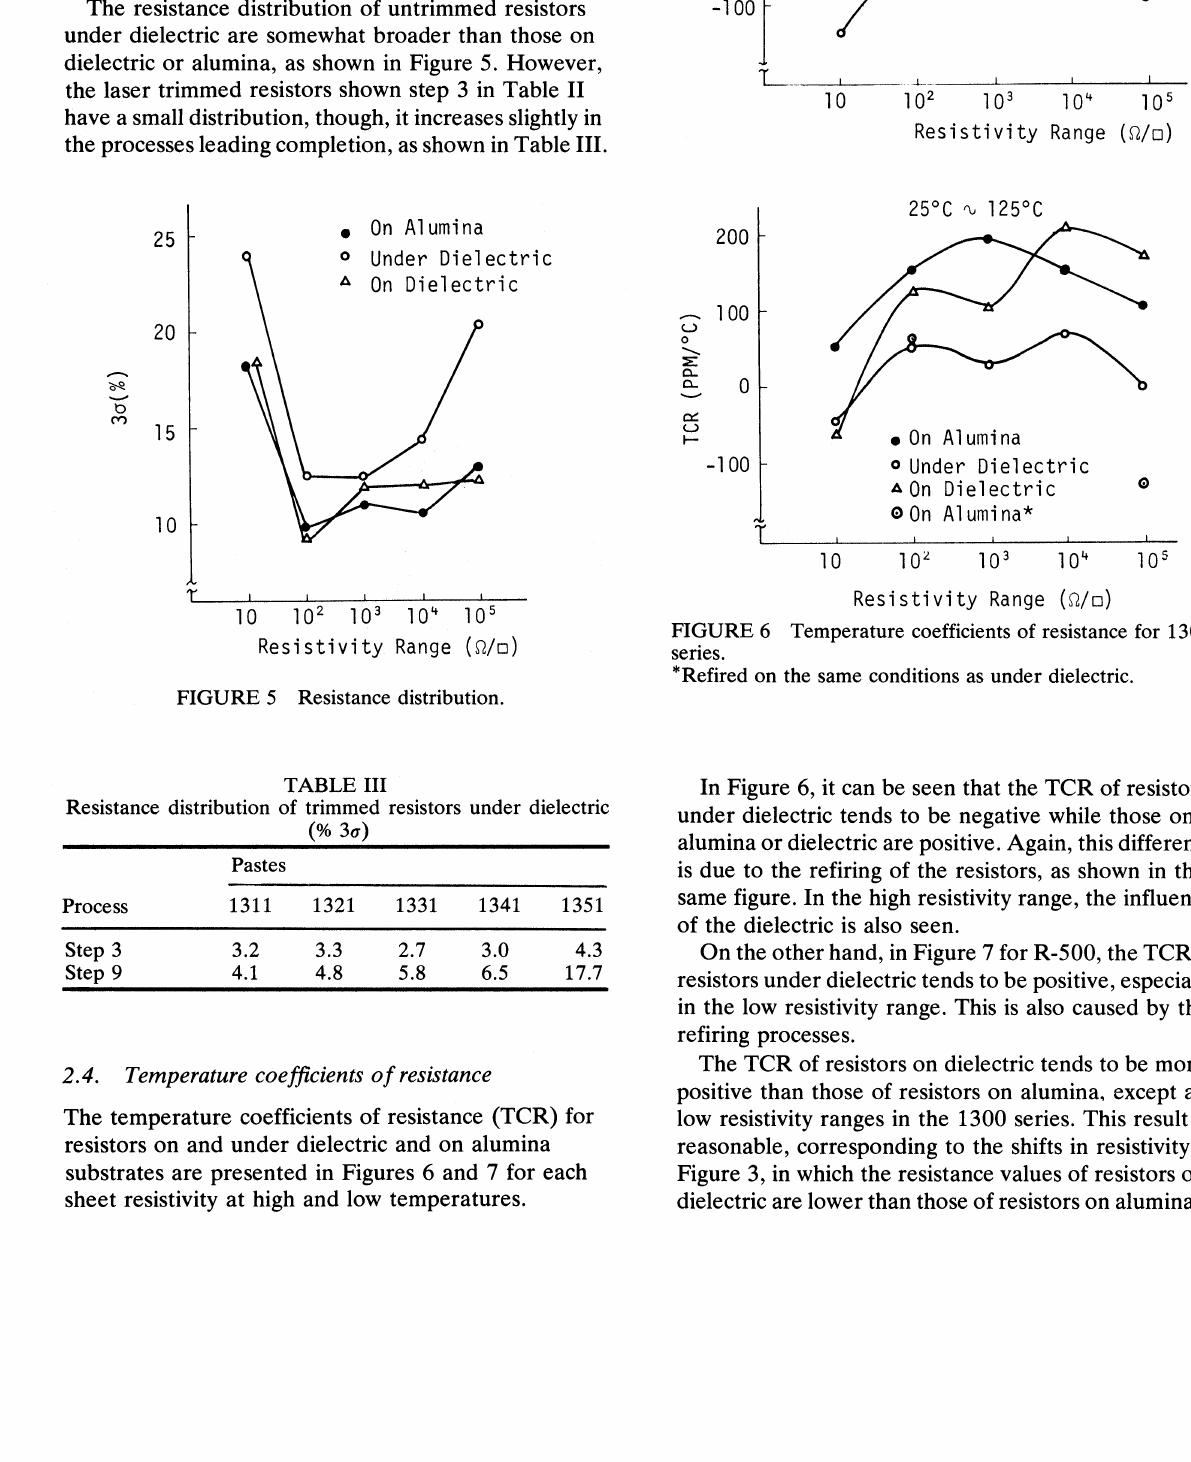
FIGURE 6 Temperature coefficients of resistance for 1300 series. *Retired on the same conditions as under dielectric.